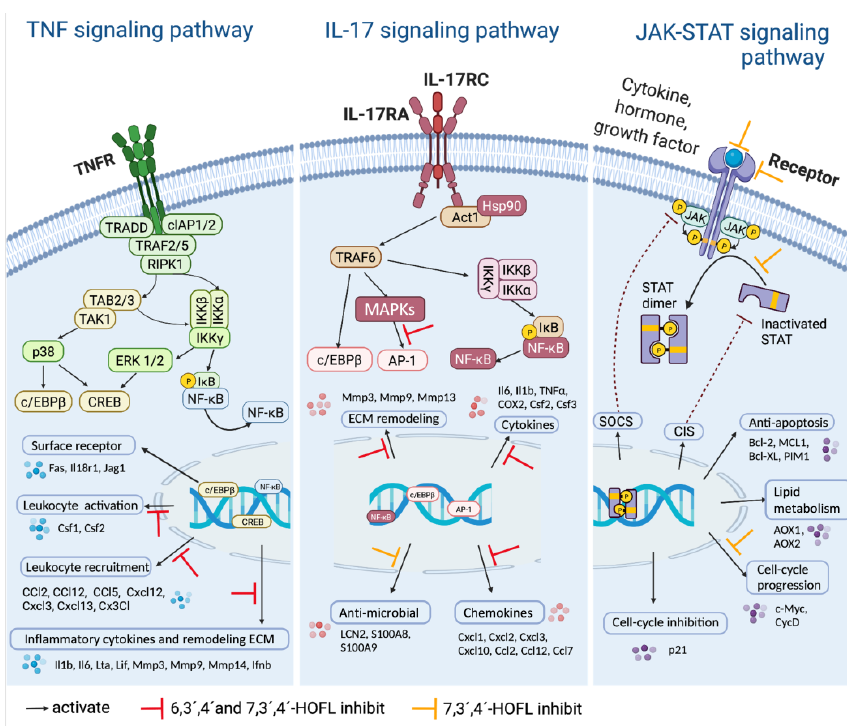
Figure 5. Schematic diagram of the signaling pathways. Created with BioRender.com.